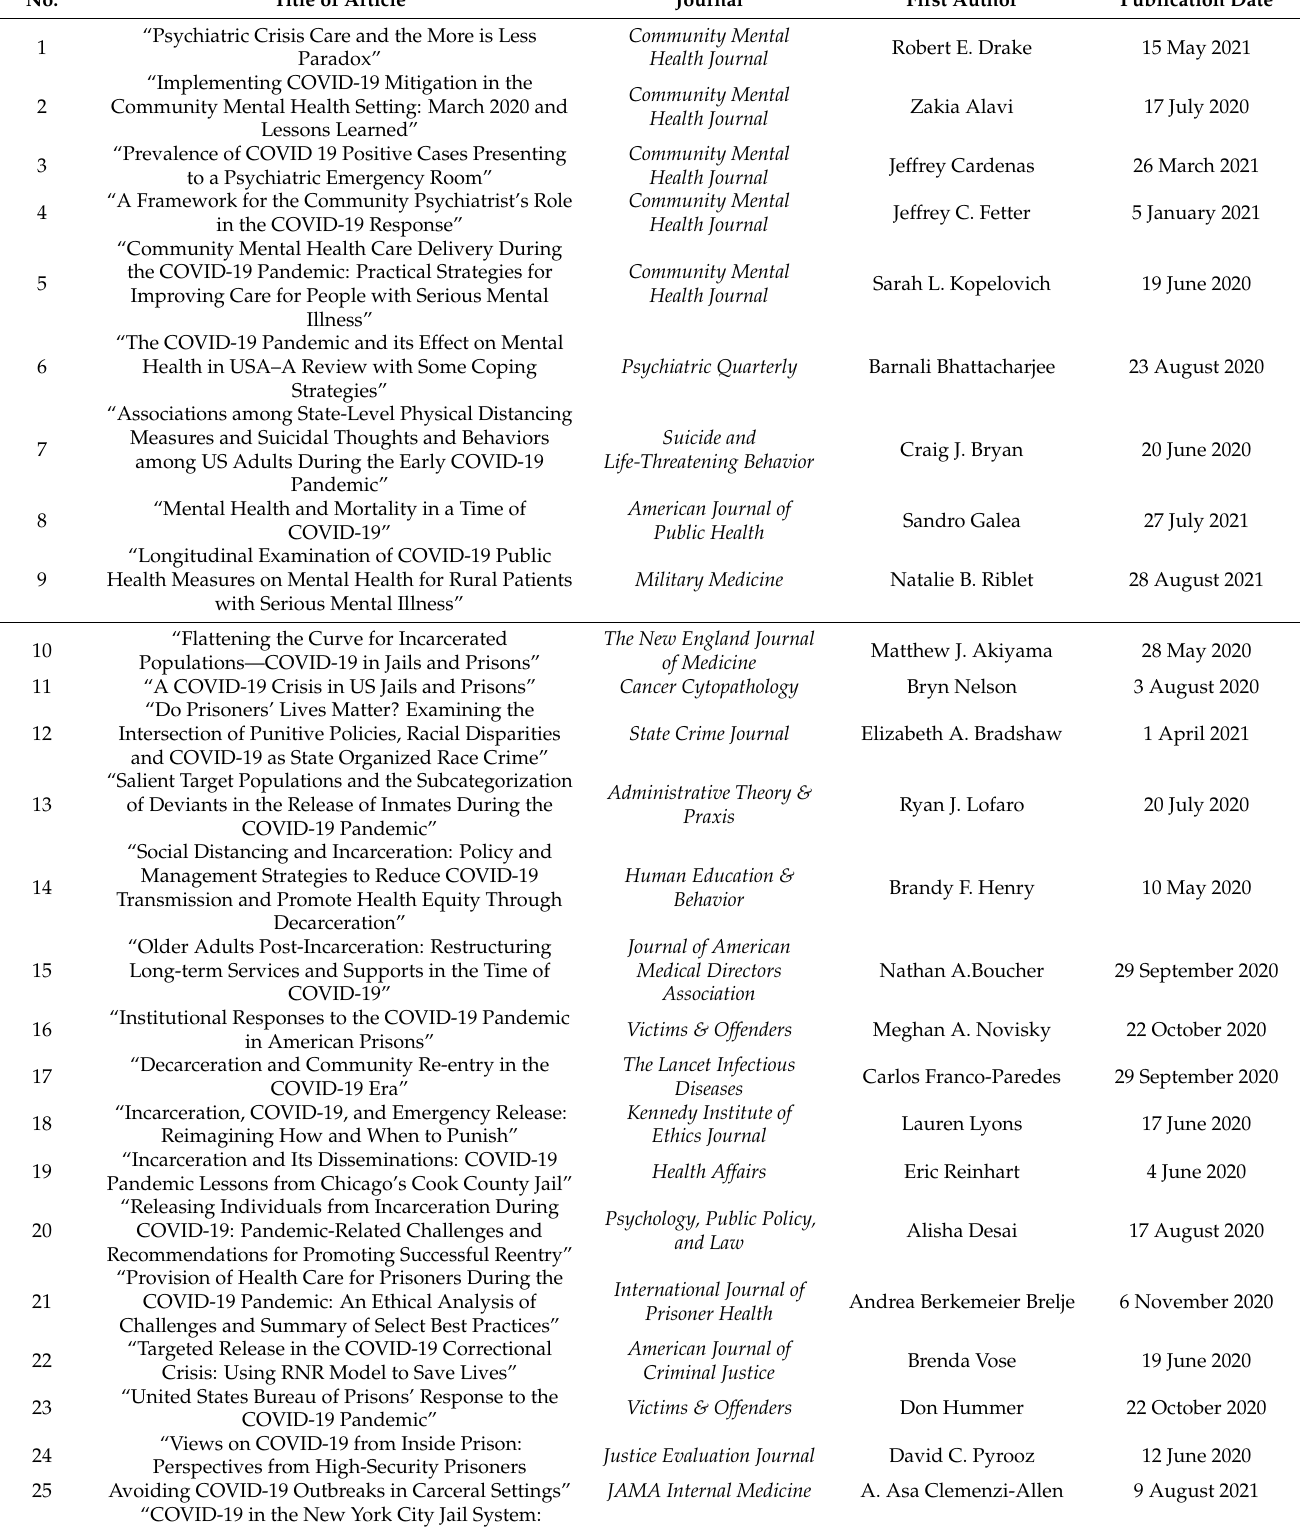
Table 1. Articles included in the systematic literature